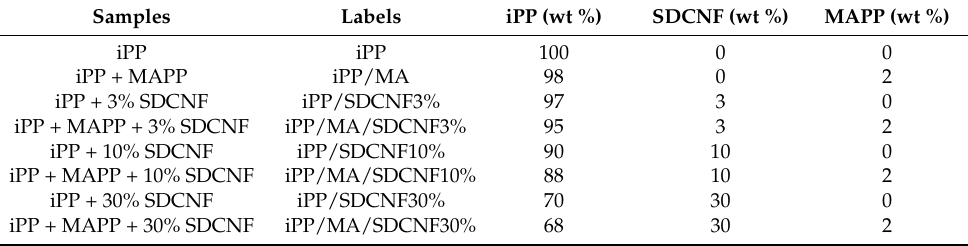
Table 2. Formulations of iPP/spray-dried cellulose nanofibrils (SDCNF)